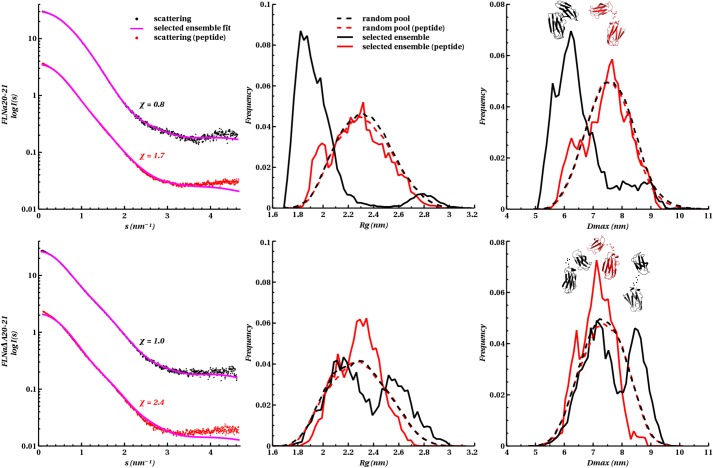
EOM modelling of migfilin peptide binding on IgFLNa(∆A)20–21.
Left panels, Fit from the selected ensemble of conformers to the experimental scattering. Radius of gyration, R
g (middle panels), and particle maximum dimension, D
max (right panels), distribution histograms of the selected conformers versus the pool. Also shown in the right panel are examples of rigid body models of the selected conformers corresponding to the histogram peaks.